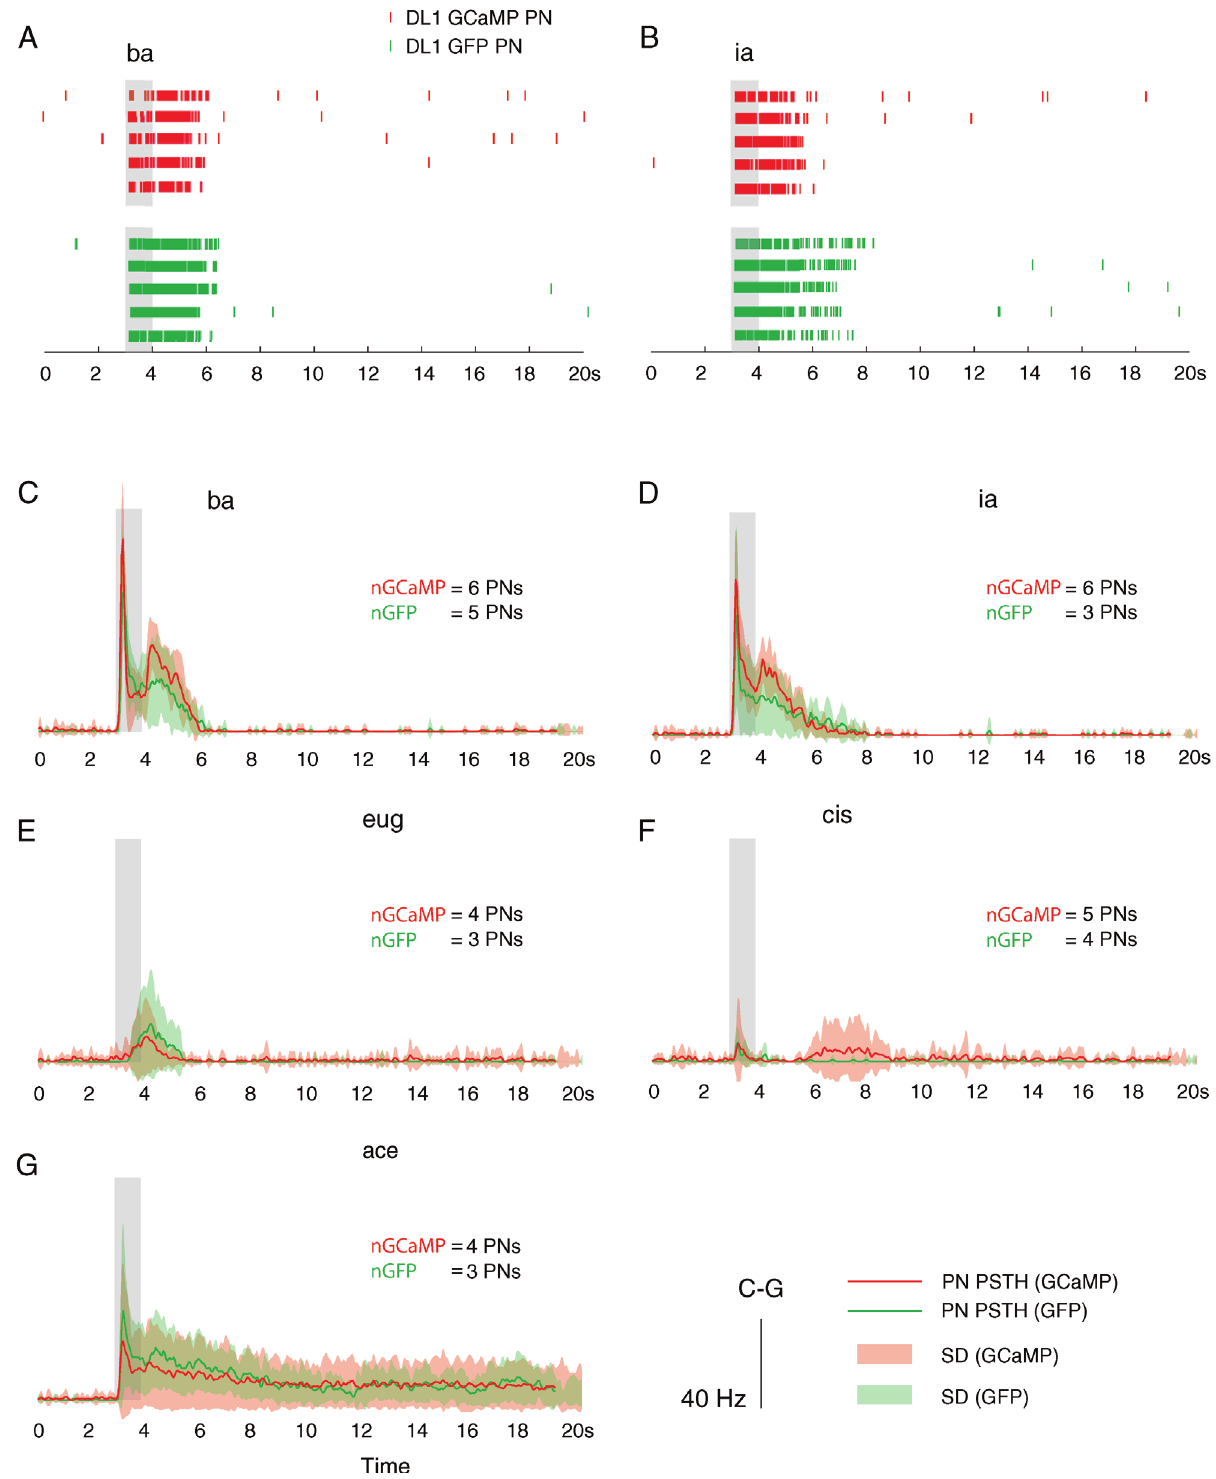
Figure 2. G-CaMP-expressingPNs(oftheDL1glomerulus)andtheirGFP-expressingcounterpartsdonotshowsignificantlydifferentresponsepatterns. ( A–B ) Sample responses of two PNs. The first five rows show spike rasters of single trial responses of a G-CaMP-expressing PN (NP3529-Gal4, UAS-GCaMP) fly, and the next five show responses of a GFP-expressing PN (NP3529-Gal4, UAS-eGFP) to ba and ia respectively. ( C–G ) Shown are mean PSTHs for DL1PN: GFP (in green, with SD in light green) and G-CaMP (in red; SD in pink). PN spiking responses to different odors shown were smoothed (5ms width Gaussian) before trial-averaging to produce PSTHs. G-CaMP PN responses were almost always within one SD of GFP PN responses (see stats in